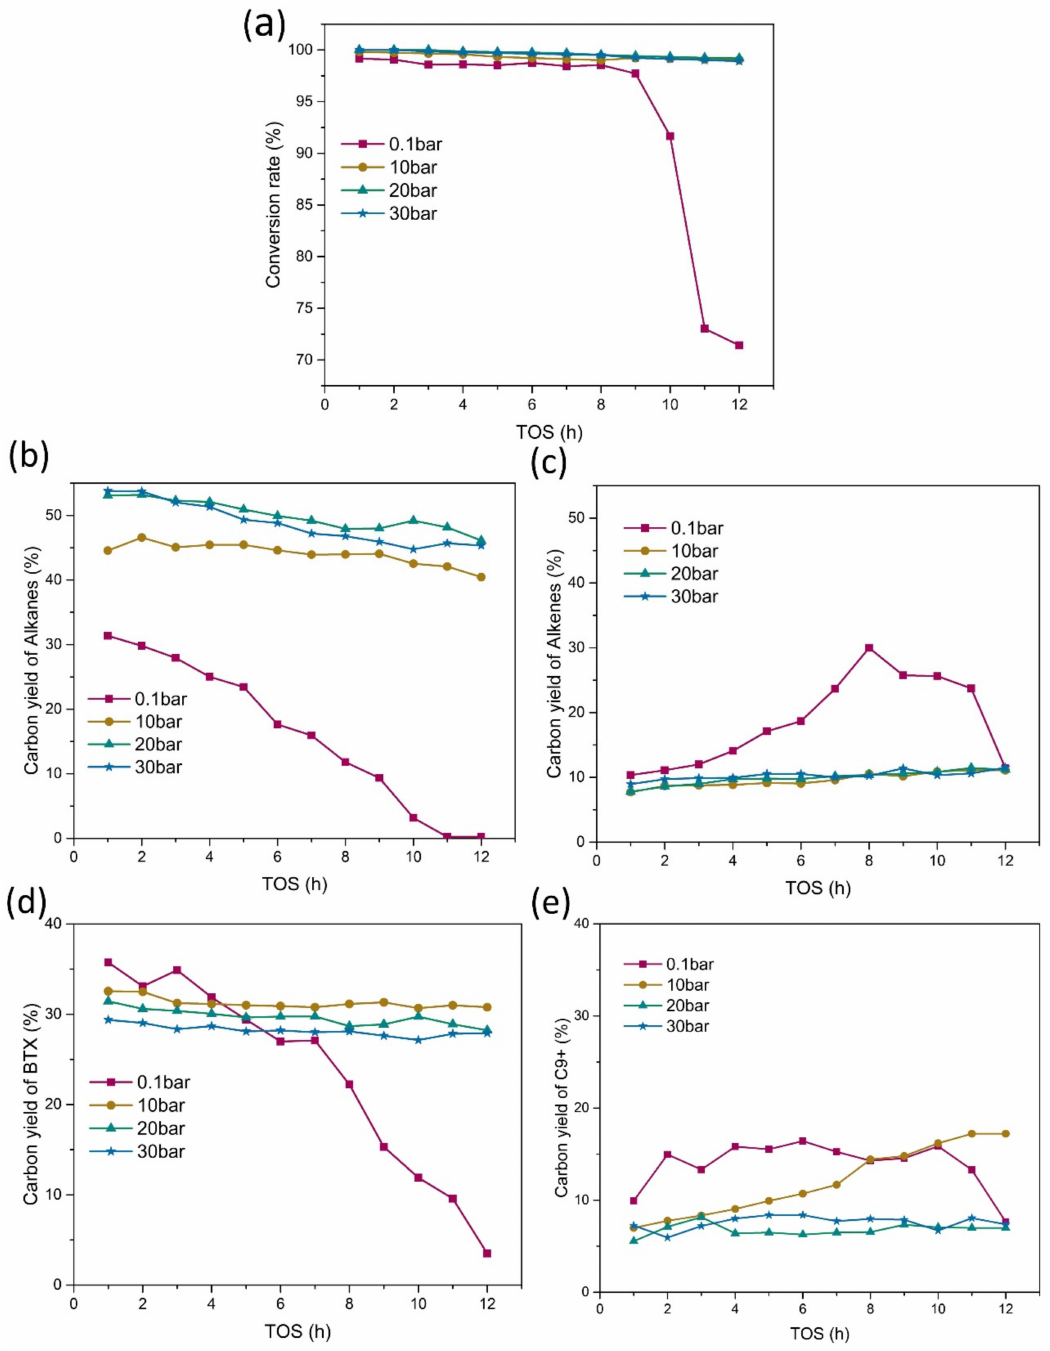
Figure 5. Conversion rate and major product distribution with different hydrogen pressure (catalytic temperature: 400 ◦ C, W/F = 0.073 g cat (mmol feed h − 1 ) − 1 : ( a ) conversion rate, ( b ) alkanes, ( c ) alkenes, ( d ) MAHs, ( e )